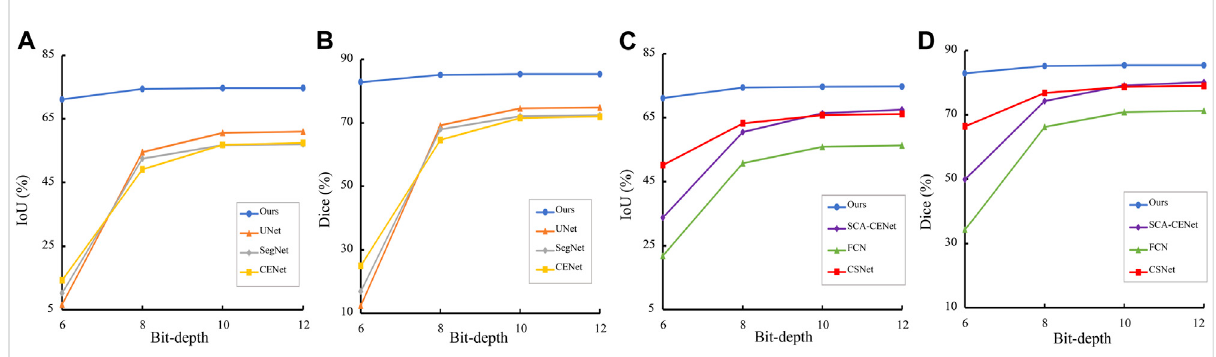
FIGURE 9 Trend of Dice and IoU results of different segmentation methods in different bit depth images. (A) , (C) are the result on the COSTA-H dataset, and (B) , (D) are the result on the COSTA-T dataset.